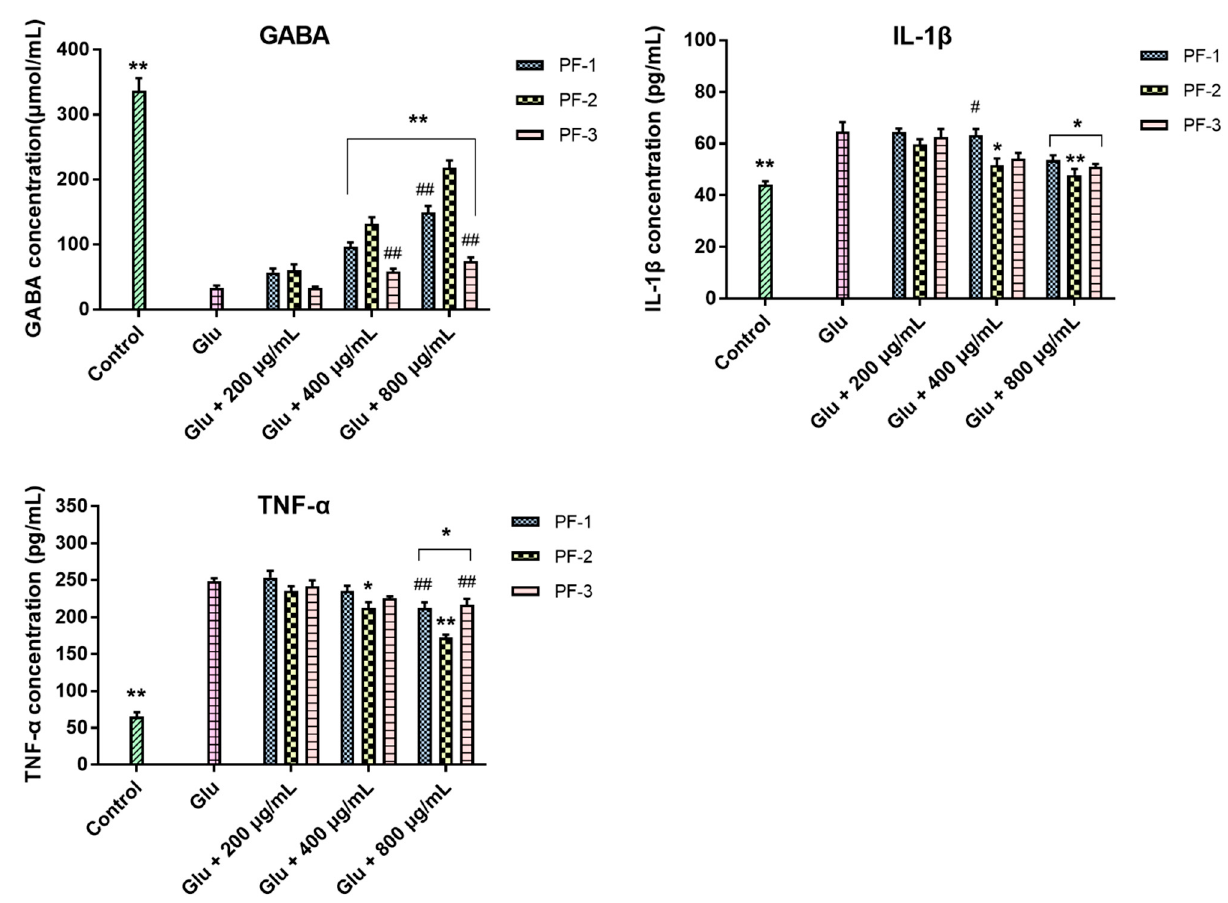
Figure 4. Effects of PF-1, PF-2 and PF-3 on the GABA, IL-1 β , and TNF- α level in Glu-injured PC12 Cells. Cells were treated with corresponding fractions at concentrations of 200, 400 and 800 µ g/mL for 24 h, subsequently with Glu (the final concentration of 20 mM) for another 24 h. # p < 0.05 vs. the PF-2 group at the same concentration, ## p < 0.01 vs. the PF-2 group at the same concentration, * p < 0.05 vs. the Glu-treated group, ** p < 0.01 vs. the Glu-treated group.